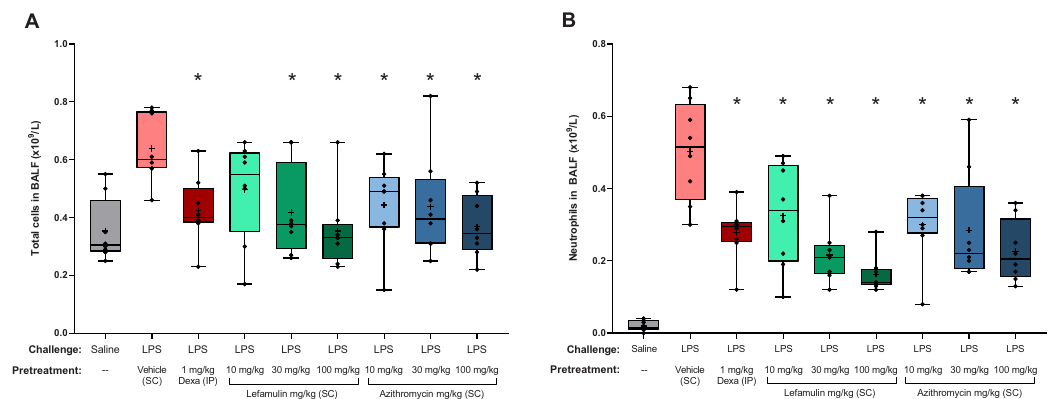
Fig 1. (A) Total and (B) neutrophil cell counts in BALF after LPS induction. BALF, bronchoalveolar lavage fluid; Dexa, dexamethasone; IP, intraperitoneal; LPS, lipopolysaccharide; SC, subcutaneous. Box and whisker plots show 25% percentile, median, and 75% percentile in box, with minimum and maximum values shown with whiskers. Means are shown with “+” and raw data points with black circles. � P < 0.05 vs LPS/vehicle via Mann-Whitney test.